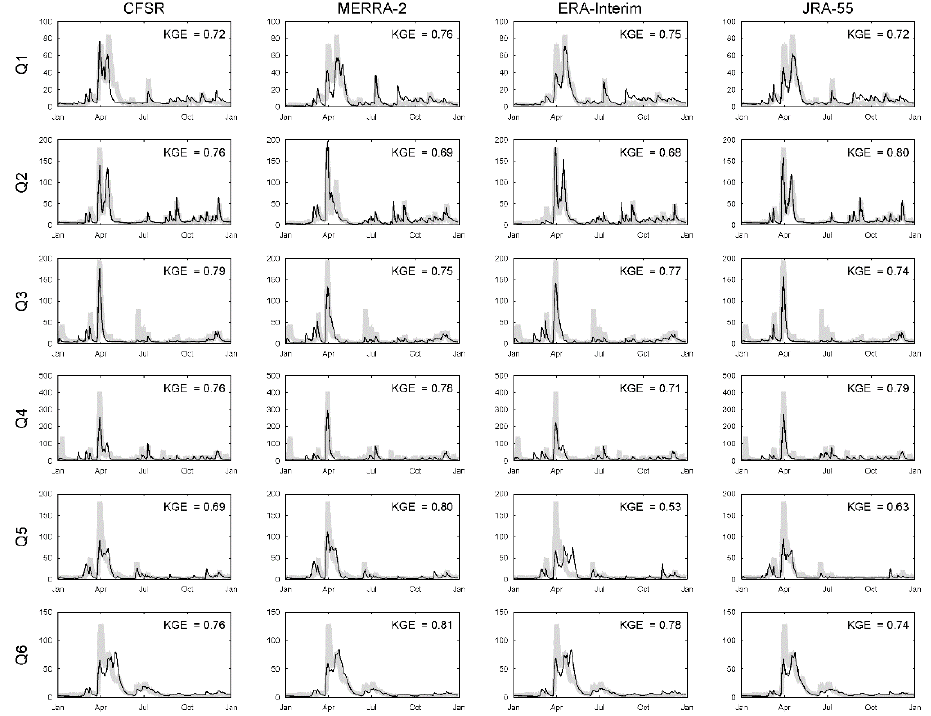
Figure 3. Observed and simulated 2008 hydrographs at sites Q1 to Q6. Hydrographs are simulated with raw HRW fields taken from CFSR, MERRA-2, ERA-Interim, and JRA-55 reanalyses.